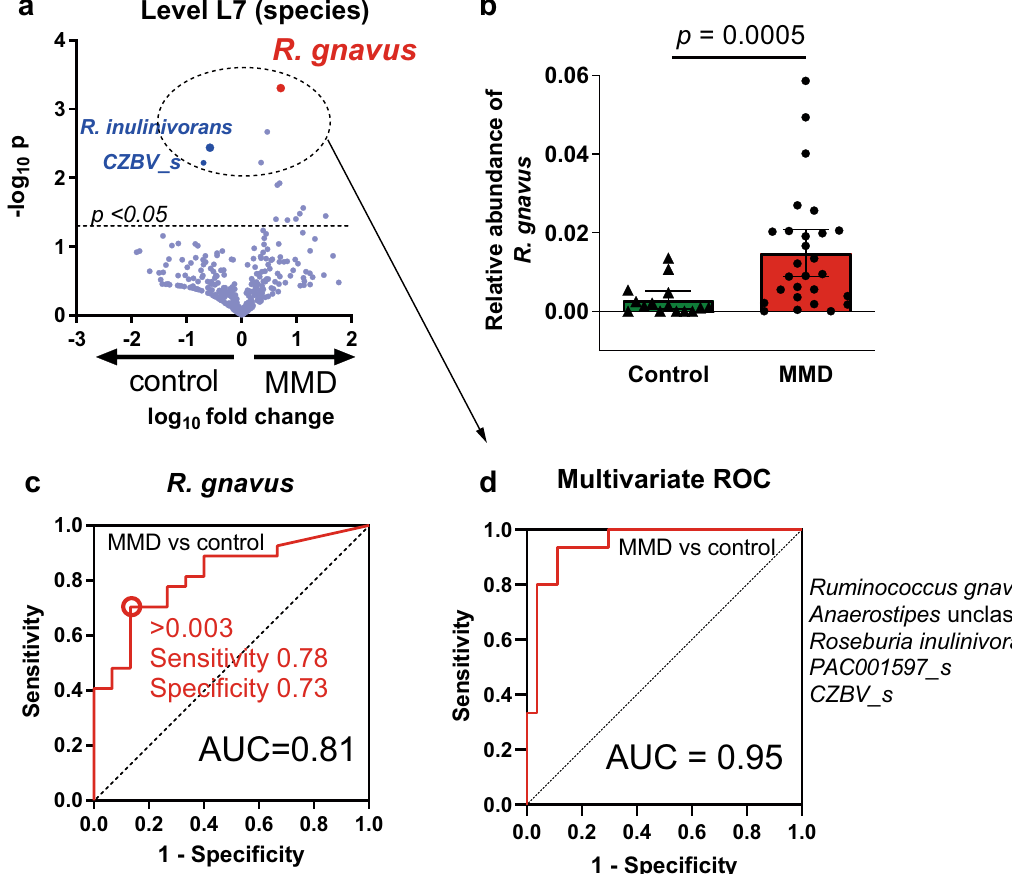
Figure 3. Association of R. gnavus with MMD. ( a ) The volcano plot showed R. gnavus had the lowest p value. ( b ) The relative abundance of R. gnavus was higher in MMD than in controls. Bars and whiskers indicate means and standard deviations. ( c-d ) Univariate ( c ) and multivariate ( d ) Receiver Operating Characteristics (ROC) analysis indicated that the relative abundance of R. gnavus has good discrimination capacity for MMD. Univariate analysis Odds ratio (95% CI) P